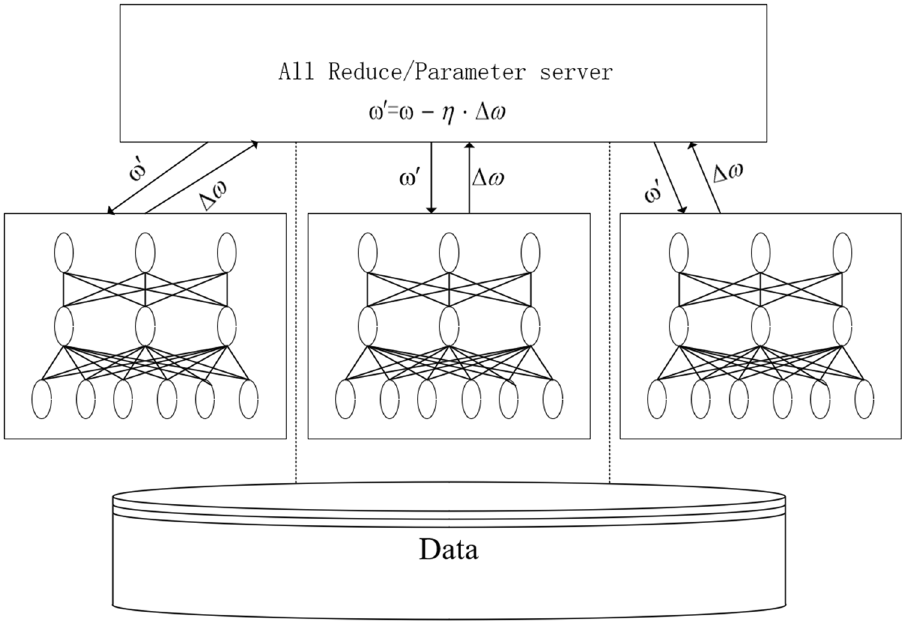
Figure 1. Deep neural network data